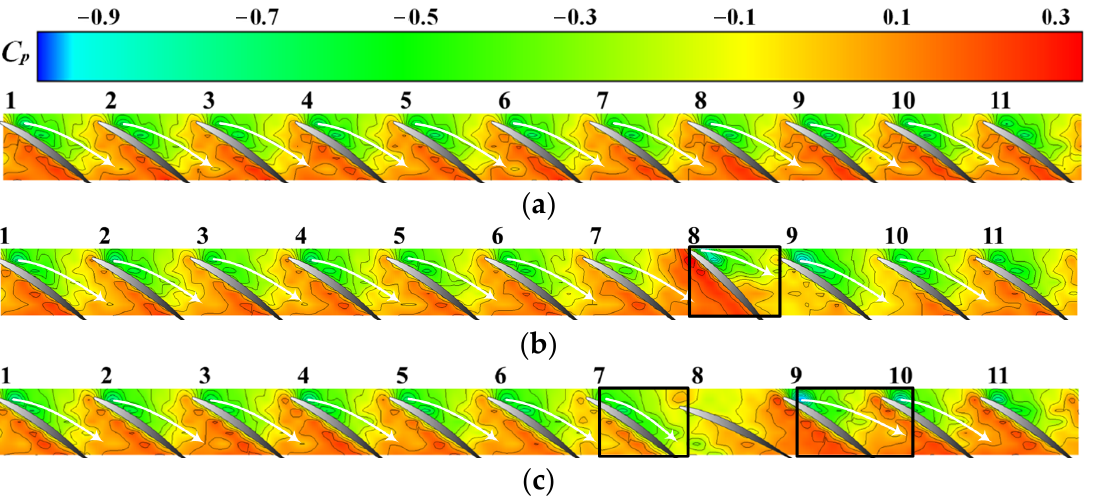
∆ β for Case 2 ( Φ = 0.580).